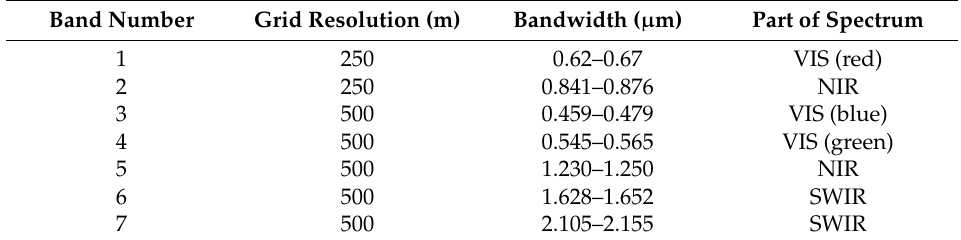
Table 1. MODIS Bands 1 to 7 spatial and spectral